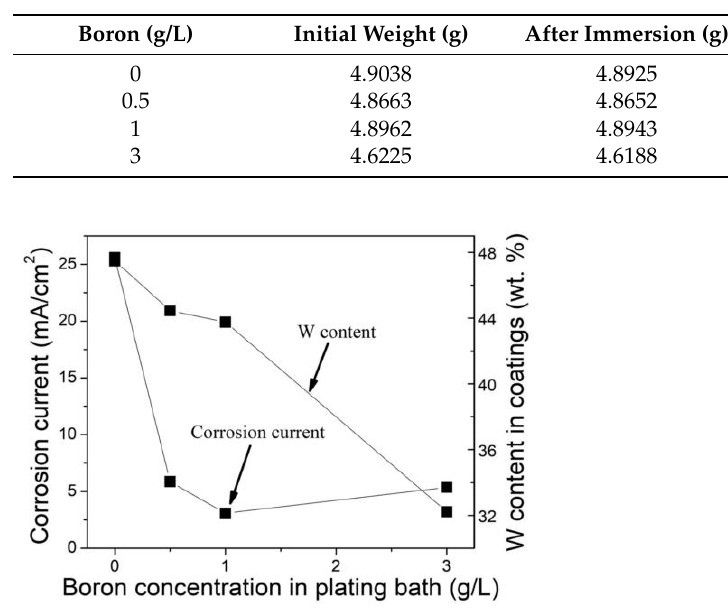
Figure 6. SEM images of ( a ) Ni-W alloy and Ni-W/B nanocomposite coatings with varying boron concentrations: ( b ) 0.5 ( c ) 1, and ( d ) 3 g/L after immersion testing. concentrations: ( b ) 0.5 ( c ) 1, and ( d ) 3 g/L after immersion testing. Table 2. Weight loss of the Ni-W and Ni-W/B coatings after immersion testing in 3.5 wt.% NaCl solution for 200 h.